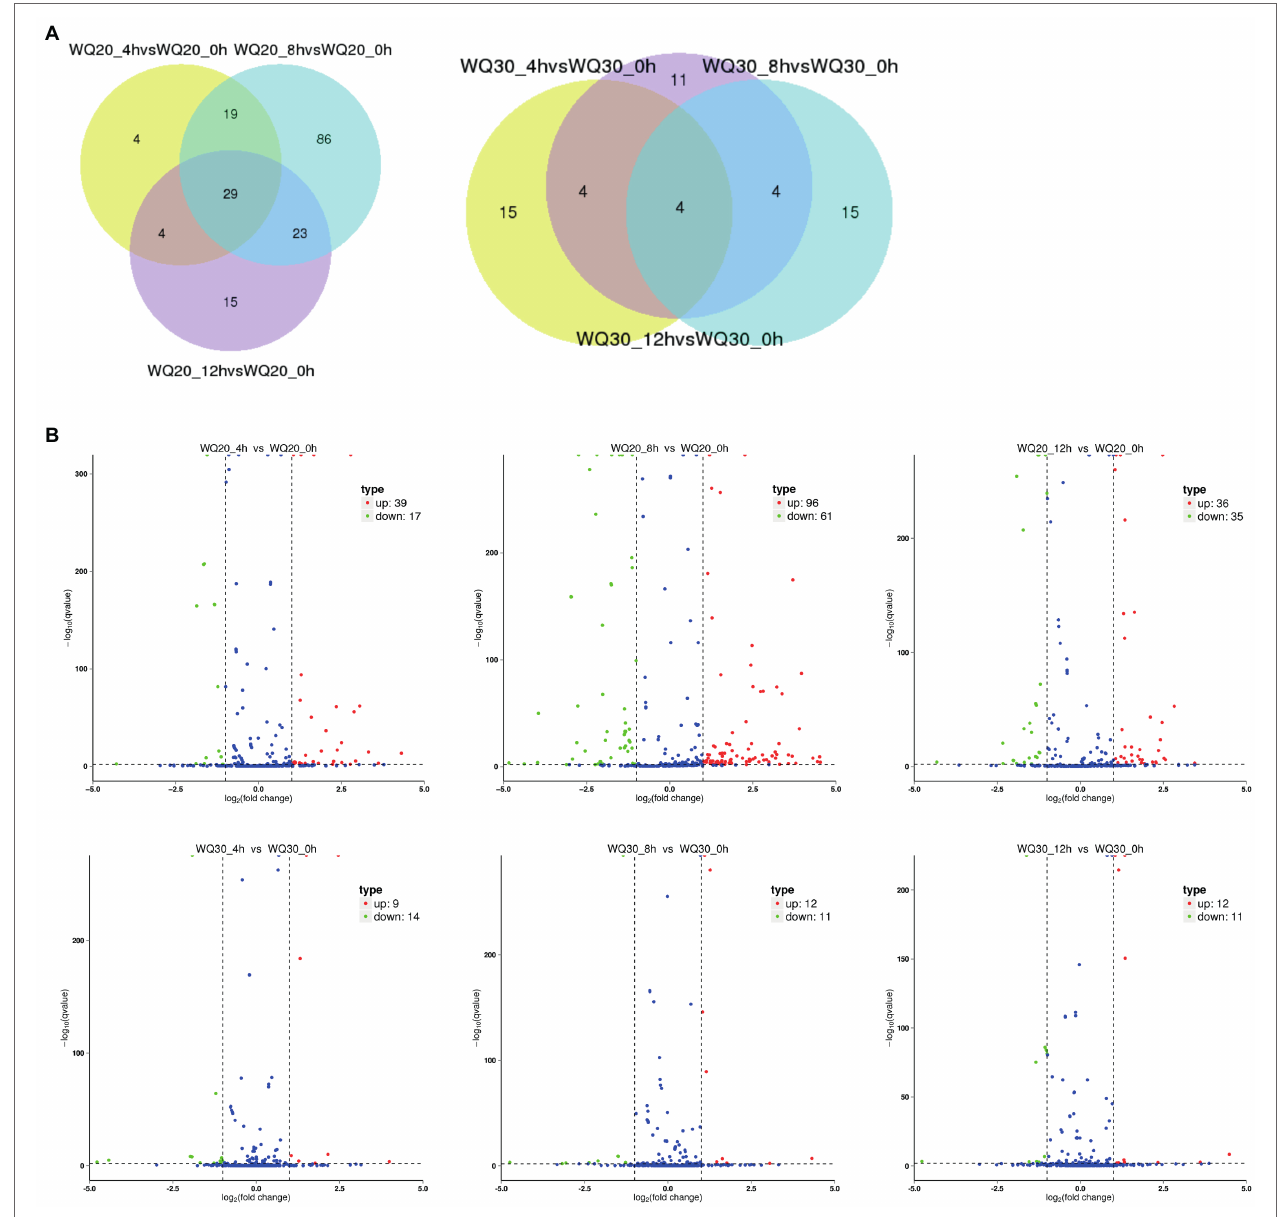
FIGURE 2 | Differentially expressed miRNAs in two peanut RILs. (A) Venn diagrams showing the number of common and specific miRNAs in comparisons of the eight libraries. (B) Volcanic diagrams showing the number of differentially expressed miRNAs in each comparison. The red dots indicate miRNAs with significant differences, and the blue dots indicate that the difference was not significant for miRNA